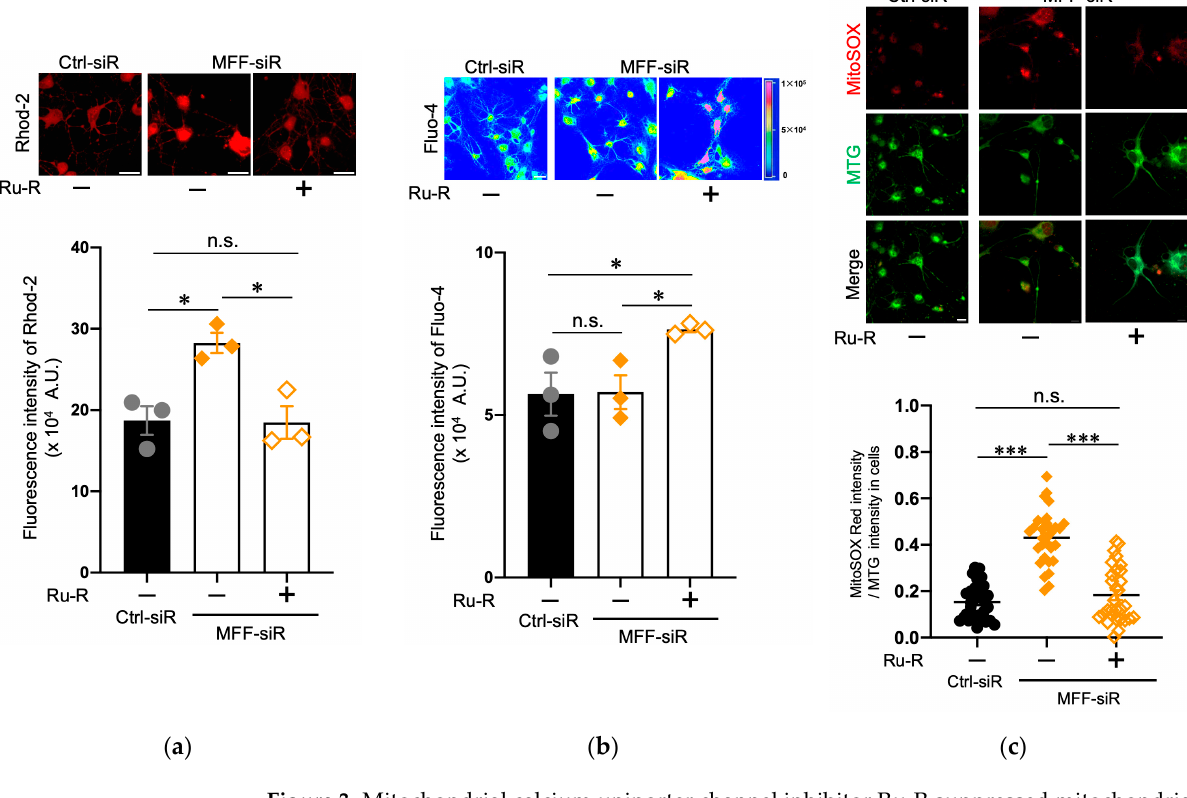
Figure 3. Mitochondrial calcium uniporter channel inhibitor Ru-R suppressed mitochondrial Ca 2+ and ROS accumulation in DNs with MFF insufficiency. Stem cells from human exfoliated deciduous teeth were differentiated into DNs in the absence or presence of Ru-R. ( a ) DNs stained with Rhod-2 AM were observed by confocal microscopy. Scale bars = 25 μ m. Fluorescence intensity of Rhod-2 AM was measured using a plate reader. The mean ± SEM was taken from three independent experiments. n.s., not significant, * p < 0.05. ( b ) DNs stained with Fluo-4 AM were observed by confocal microscopy. Scale bar = 25 μ m. Fluorescence intensity of Fluo-4 AM was measured using a plate reader. The mean ± SEM was taken from three independent experiments. n.s., not significant, * p < 0.05. ( c ) DNs stained with MitoSOX Red and MTG were observed by confocal microscopy. Scale bar = 25 μ m. To measure the ROS level per mitochondrion, the fluorescence intensity of MitoSOX Red was divided by that of MTG. The mean ± SEM was taken from three independent experiments. n.s., not significant, *** p < 0.001.